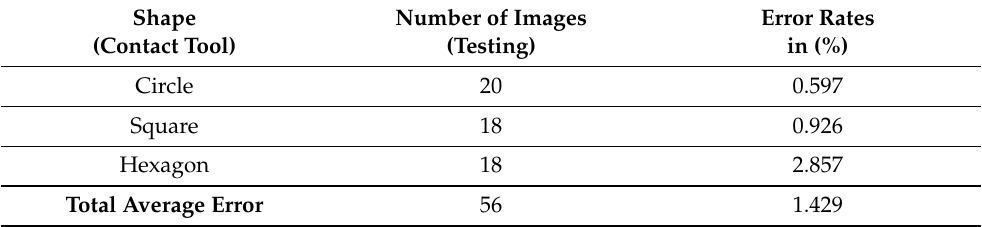
Table 6. Contact area estimation w.r.t different shaped contact tools (circular, hexagonal, and